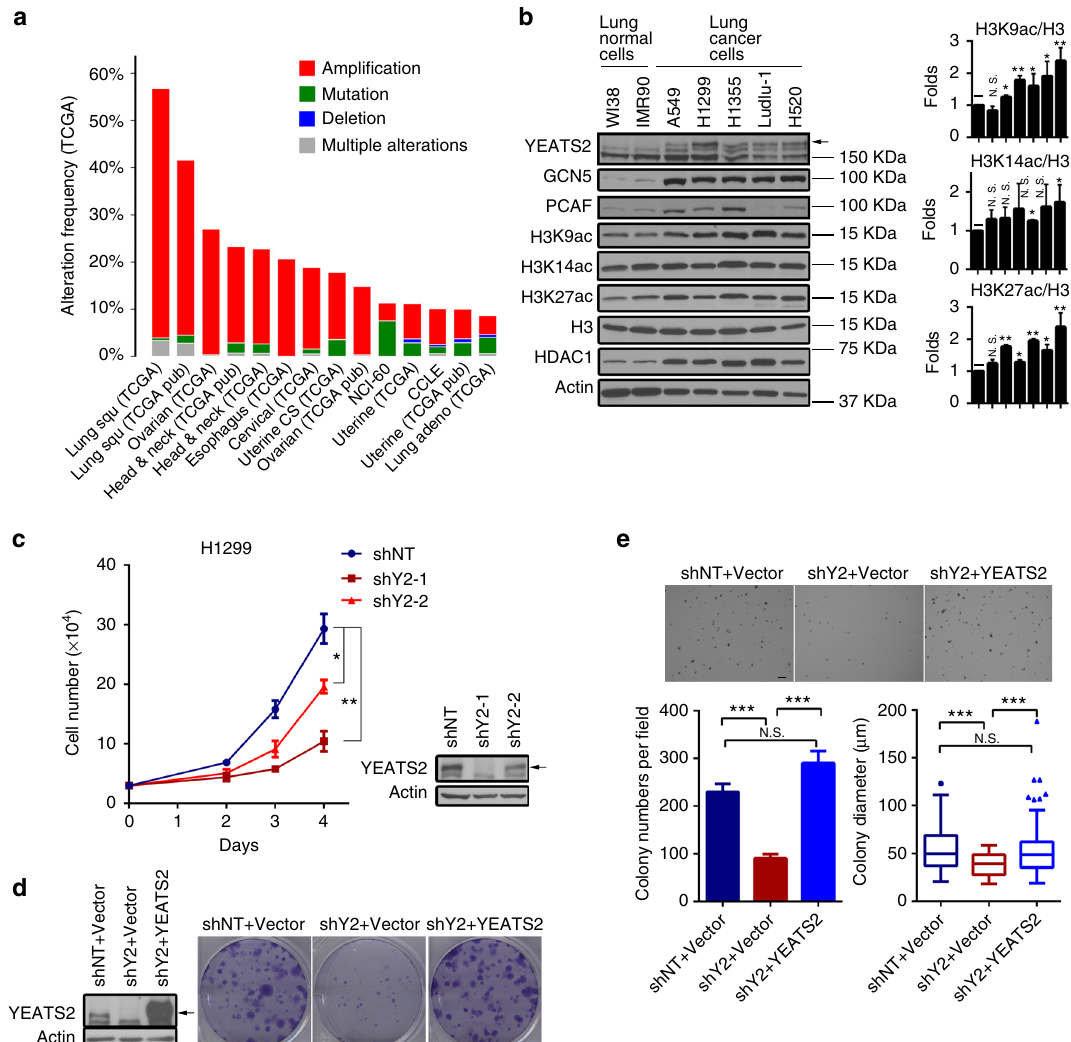
Fig. 1 YEATS2 is ampli fi ed in NSCLC and is required for cancer cell growth and survival. a YEATS2 gene is frequently ampli fi ed in various types of human cancers. Data was obtained from the cBioPortal for Cancer Genomics. b Western blot analysis of YEATS2, GCN5, PCAF, HDAC1, and the indicated histone acetylation in NSCLC cell lines and immortalized “ normal ” lung fi broblast cell lines. Total H3 and actin are shown as loading control. The arrow indicates the band of YEATS2 protein. Relative H3K9ac, H3K14ac, and H3K27ac levels were quanti fi ed ( n = 3, mean ± s.e.m.). N.S. not signi fi cant; * p < 0.05; ** p < 0.01 (Student ’ s t -test). c Cell proliferation assay of H1299 cells treated with control (shNT) or YEATS2 shRNAs (shY2). Cells (mean ± S.E.M., n = 4) were counted for 4 days after seeding (left panel). Right panel: western blot analysis showing YEATS2 knockdown ef fi ciency. The arrow indicates the band of YEATS2 protein. Error bars represent S.E.M. * p < 0.05; ** p < 0.01 (Student ’ s t -test). d Clonogenic assay of control (shNT), YEATS2 knockdown (shY2), and knockdown H1299 cells rescued with ectopic expression of YEATS2. Empty vector was used as a control. Colonies were stained and photographed 7 days after seeding (right panel). Left panel: western blot analysis of YEATS2 expression level in indicated cells. The arrow indicates the band of YEATS2 protein. e Anchorage-independent growth assay of H1299 cells as in ( d ). Cells (mean ± S.E.M., n = 4 – 6) were stained with 0.005% crystal violet blue and photographed 3 weeks after seeding (top panel). Colony numbers (bottom left) and colony diameters (bottom right) were measured and quanti fi ed using ImageJ software. Scale bar, 200 µ m. N.S. not signi fi cant; *** p < 0.001 (Student ’ s t